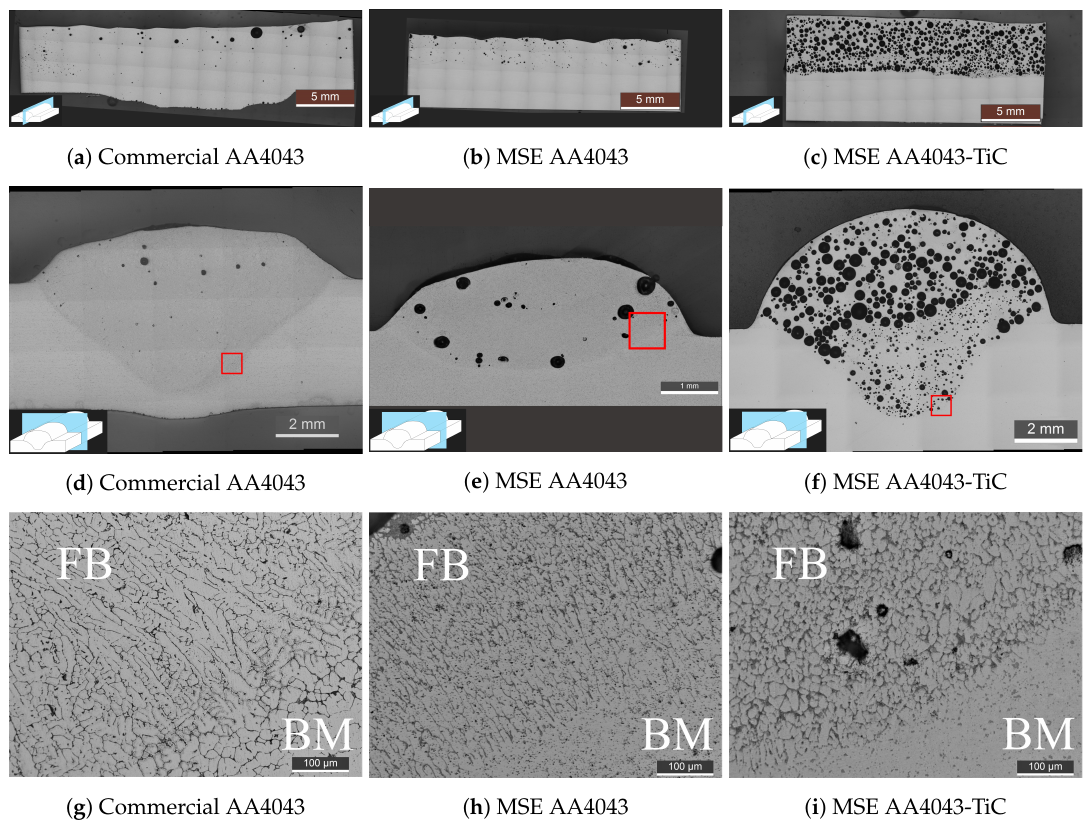
Figure 10. Bead-on-plate GMAW deposition of investigated materials in longitudinal and transverse sections. Metal screw-extruded materials are marked MSE. Micrograph image position is indicated in ( d–f ) by red rectangles. FB is fusion boundary and BM is base material. AA4043 without TiC addition possessed relatively low levels of porosity and a columnar microstructure. TiC-reinforced metal screw extruded material was highly porous and possessed an equiaxed